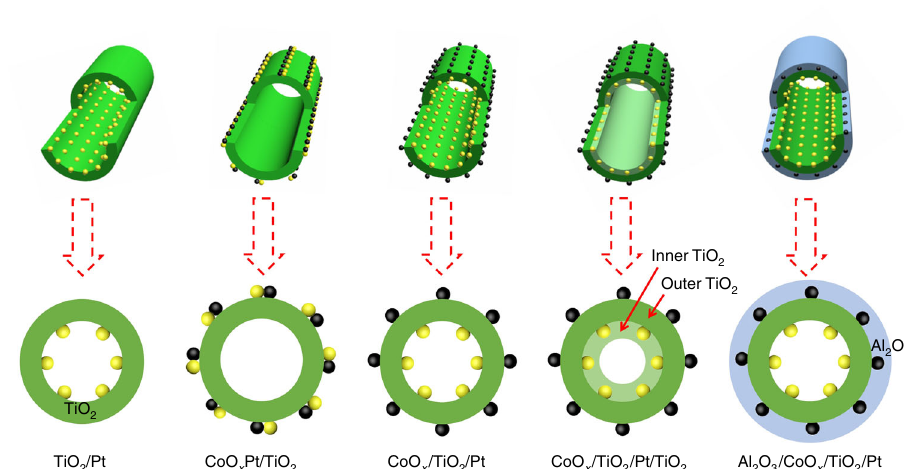
Fig. 1 Schematic illustration of the catalysts. Semi-sectional and cross-sectional views of the different catalysts prepared by ALD. The yellow and black balls represent Pt and CoO x ,